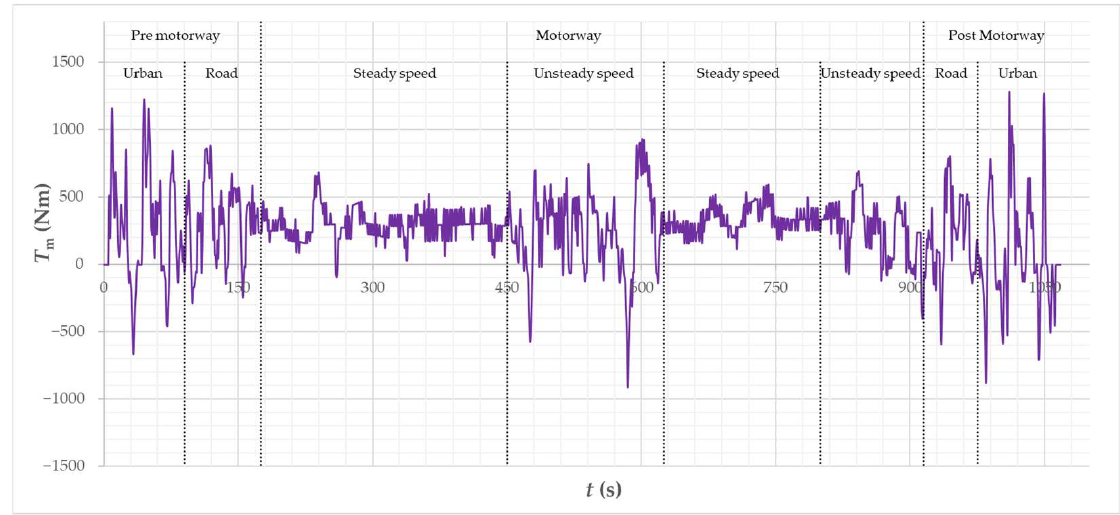
Figure 31. Calculated vehicle torque waveform of the Artemis Motorway150 cycle .